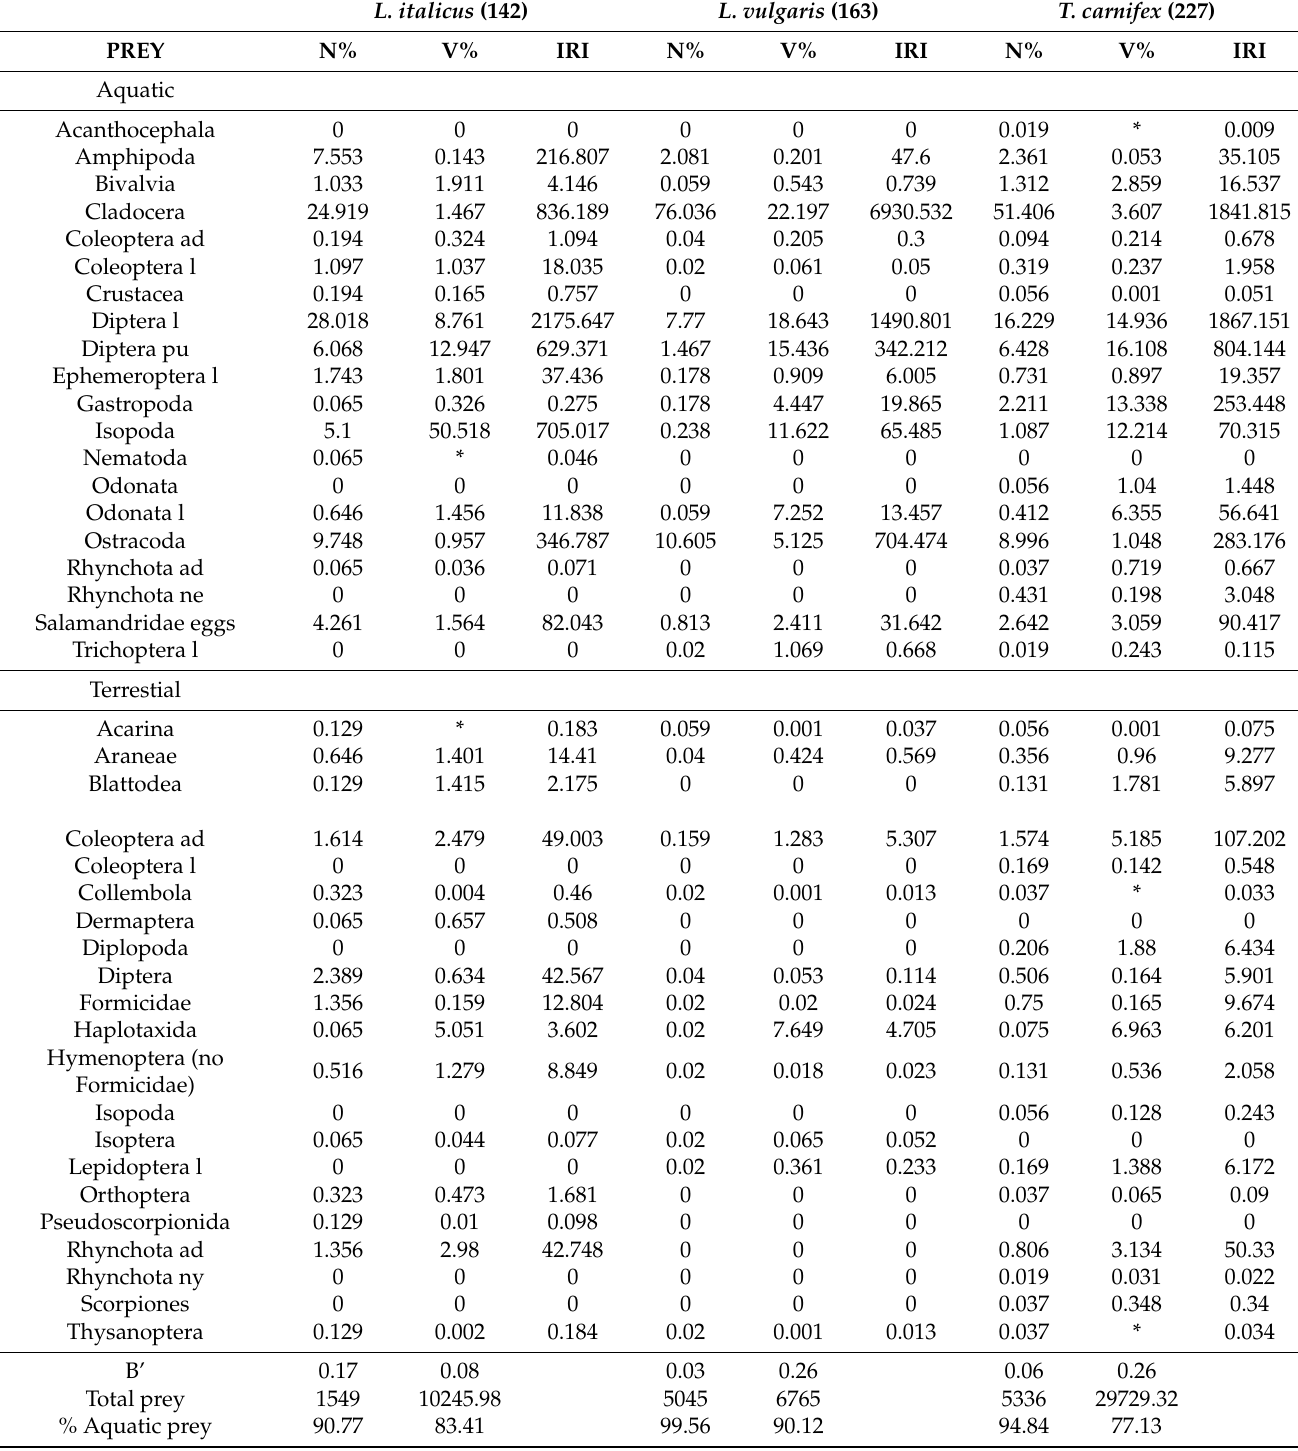
Table 1. Diet composition of Lissotriton italicus , Lissotriton vulgaris and Triturus carnifex . The number of stomachs examined is reported in brackets. N% = percentage of prey number; V% = percentage of prey volume; IRI = index of relative importance; B’ = Hurlbert Index values; ad = adult; l = larvae; ne = neanids; ny = nymphs; pu = pupae. Asterisks (*) show values <